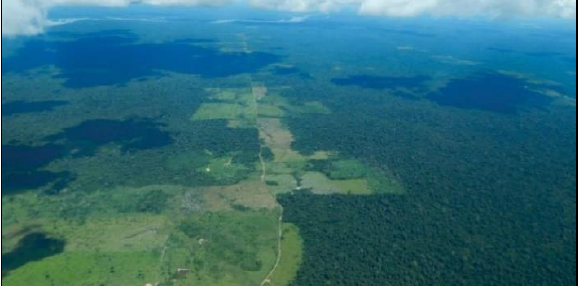
Figure 2. Top: Aerial image showing the spatial configuration of the deforestation patches along the secondary roads of the AOI. Source: personal archive of the first author.